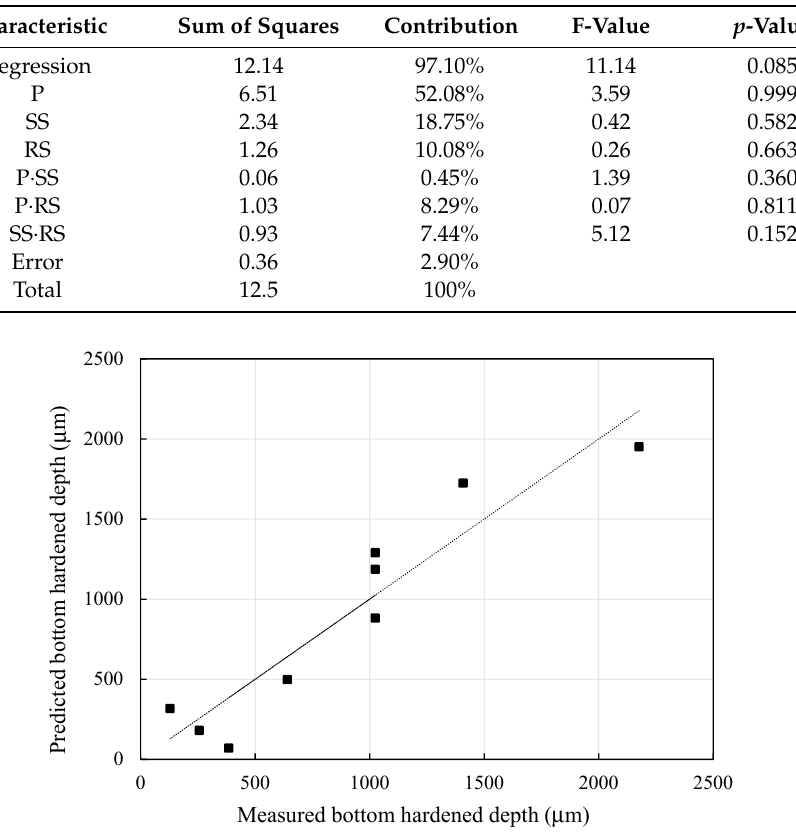
Figure 13. Measured and predicted tooth bottom hardened depth.